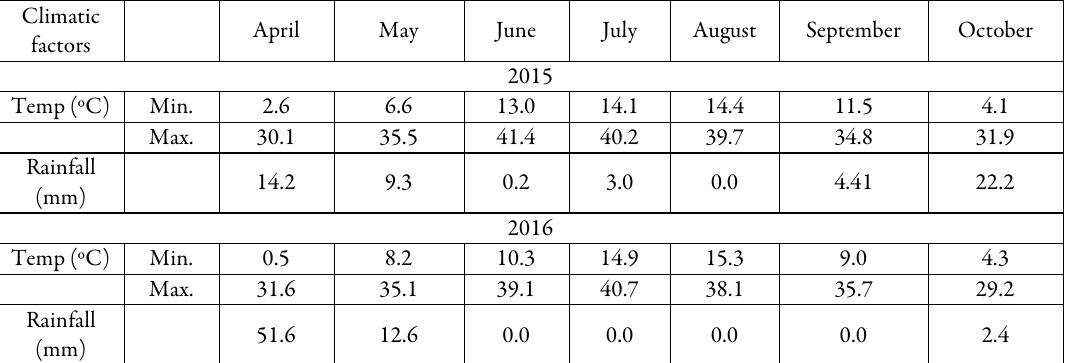
Table 1. Distribution of temperature and rainfall in 2015 and 2016